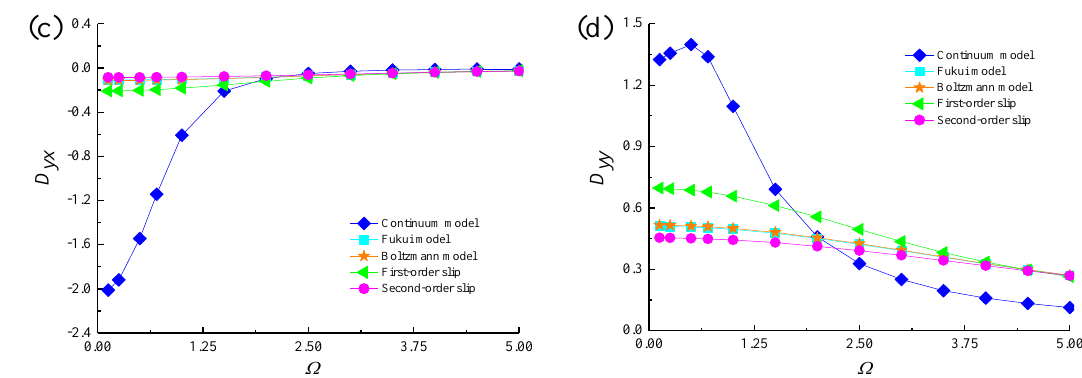
Figure 10. Effect of perturbation frequency Ω on dynamic damping coefficients of gas microbearings. ( a ) D xx vs. Ω; ( b ) D xy vs. Ω; ( c ) D yx vs. Ω; ( d ) D yy vs. Ω .